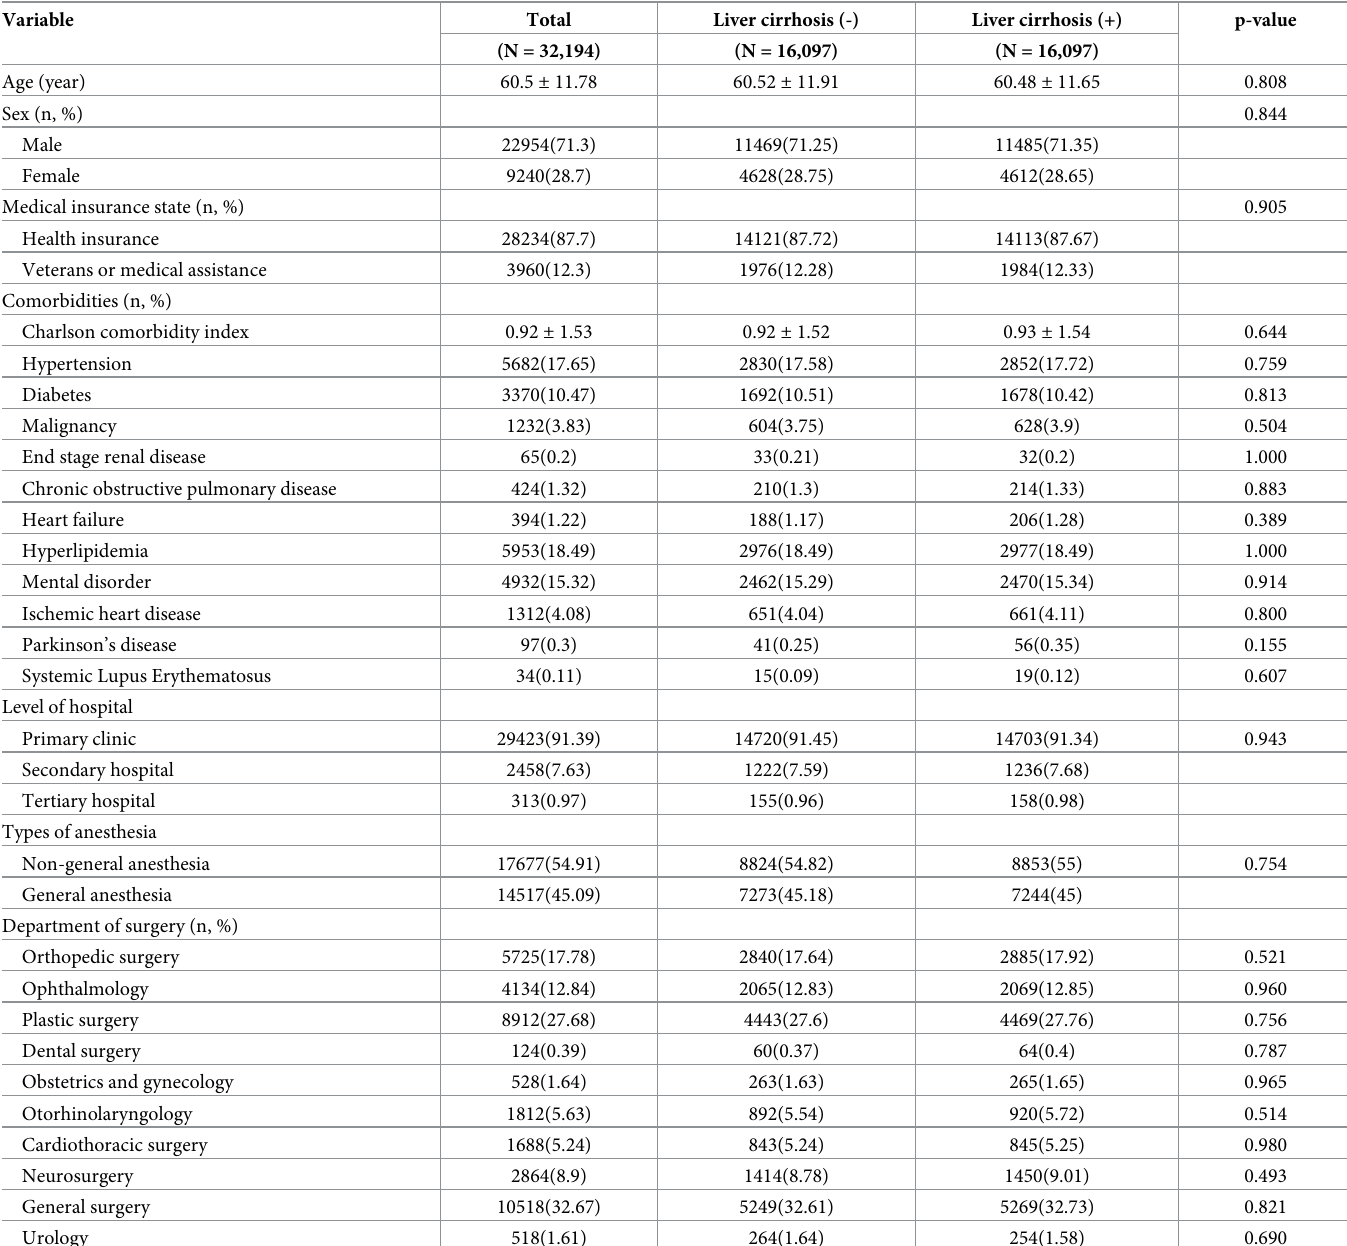
Table 3. Baseline characteristics and clinical outcomes of the matched